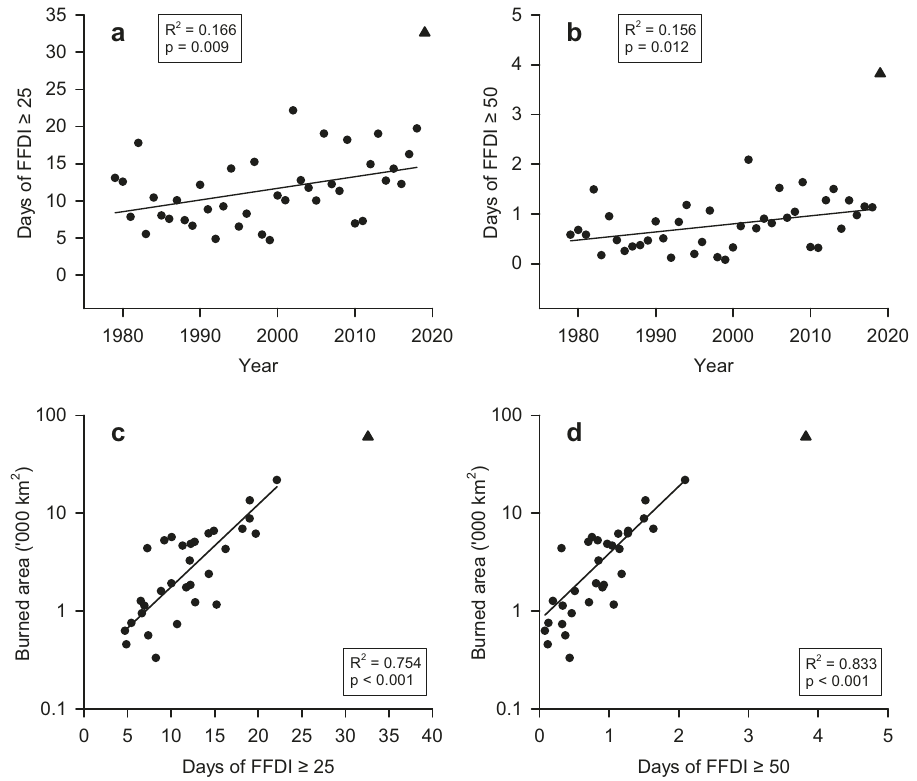
Fig. 6 Trends in the number of days with very high or severe Forest Fire Danger Index. Trends in the number of days in which Forest Fire Danger Index (FFDI) equals or exceeds ( a ) 25, linear fi t, or ( b ) 50, linear fi t, over the fi re years of 1979 to 2018 and averaged over forest ecosystems in Australia (Supplementary Table 1). Relationship between FFDI ( c ) ≥ 25 (exponential fi t) and ( d ) ≥ 50 (exponential fi t) and burned area for the fi re years of 1988 to 2019 (Supplementary Table 1, Supplementary Fig. 6c,d). 2019 fi re year (triangle). Burned area data: NOAA-Landgate (1988 –